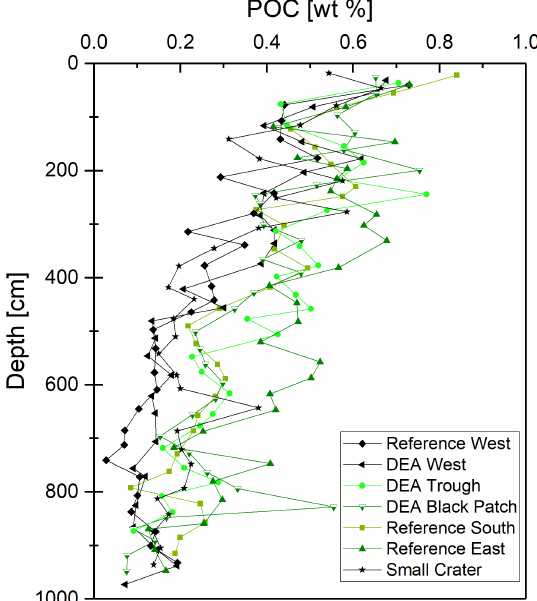
Figure 4. POC profiles of the